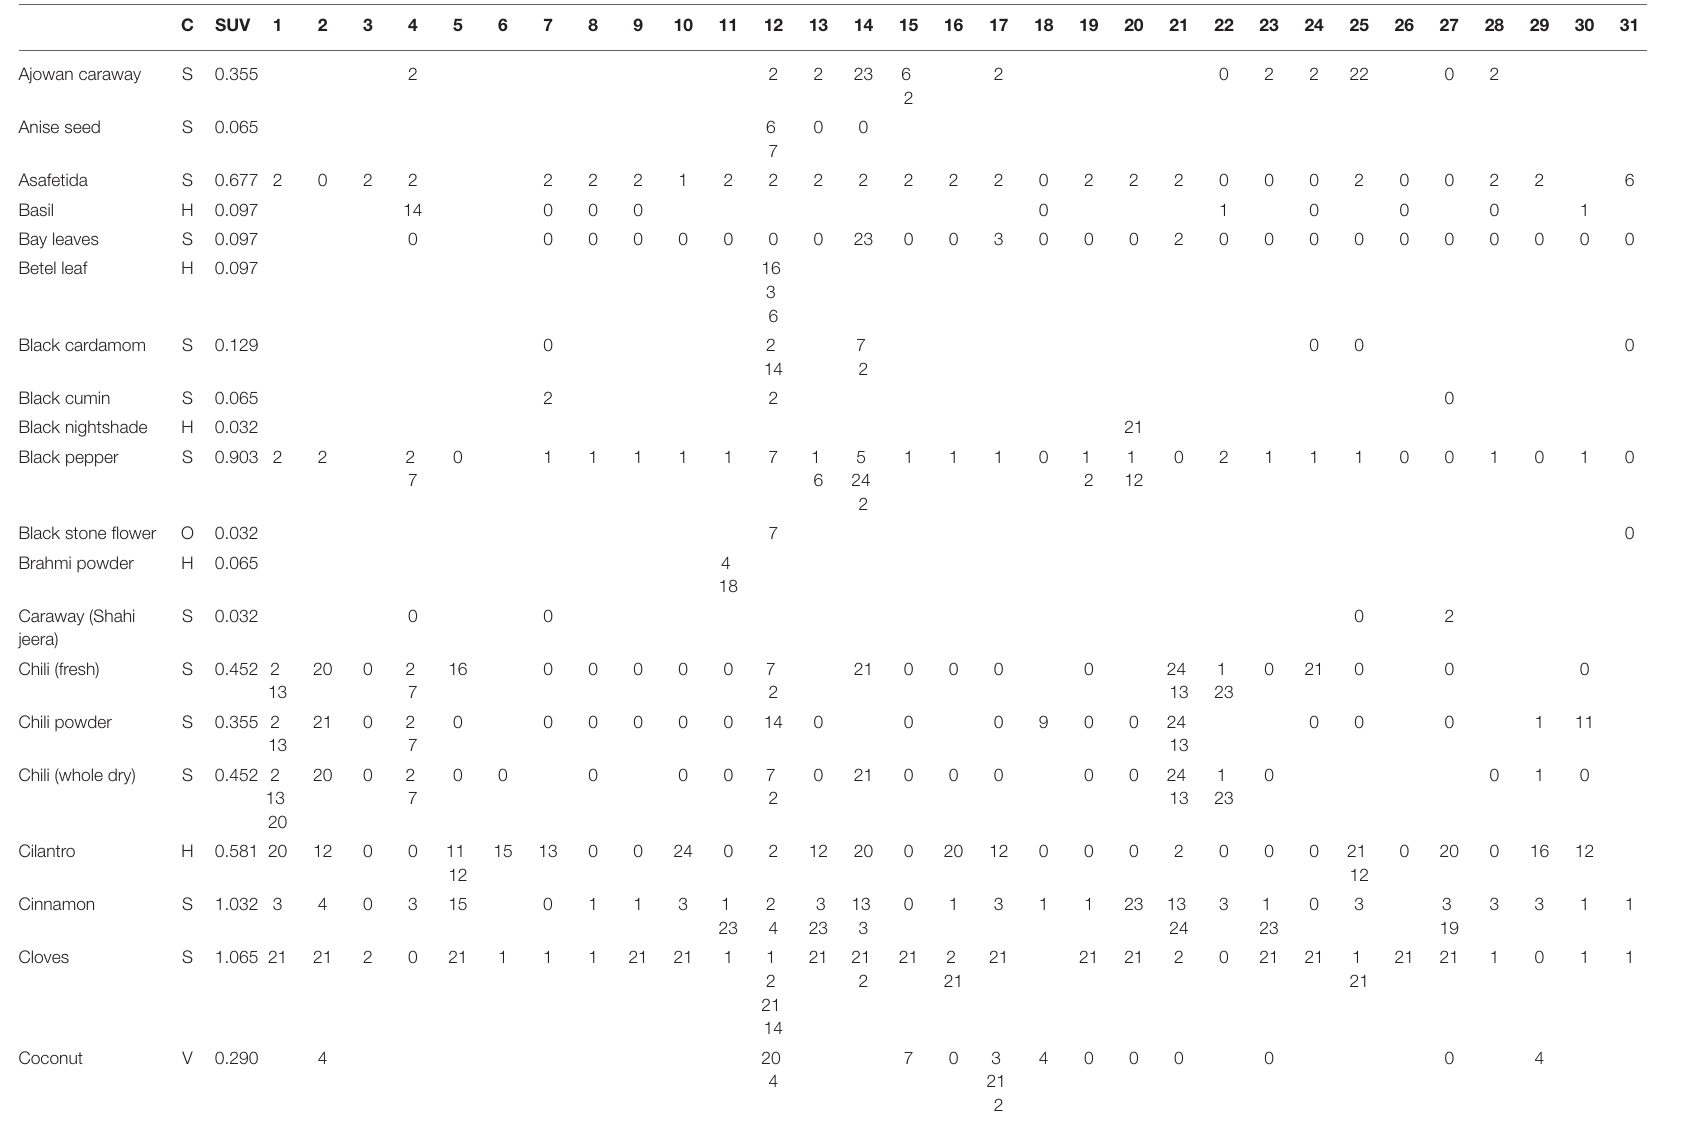
TABLE 5 | Medicinal and/or health value of spices and herbs listed by